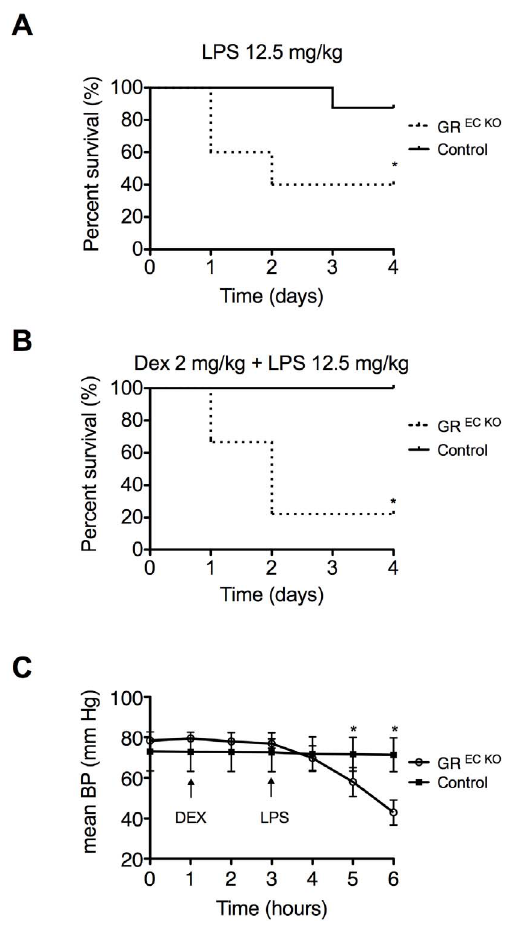
Figure 1. Impaired survival in GR EC KO mice after DEX. (A) GR EC KO miceshow increased mortalityafter LPS treatment. (B) Mortalityin GR EC KO mice is further increased in GR EC KO mice following DEX pre-treatment while controls are fully rescused following DEX + LPS. (C) Continuous blood pressure monitoring demonstrates hemodynamic instability in GR EC KO mice following pre-treatement with DEX while blood pressure is completely stabilized in control mice. *p , 0.05